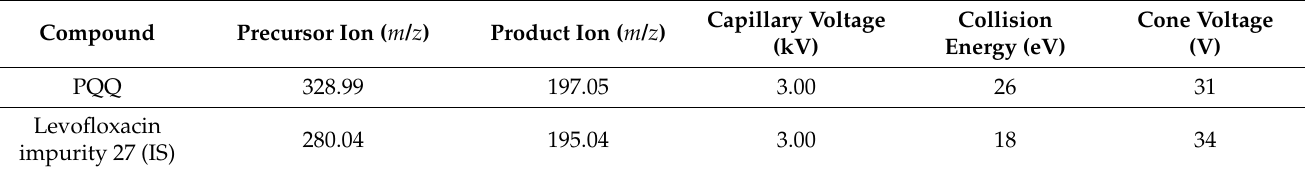
Table 1. Multiple reaction monitoring (MRM) parameters for analytes included in this